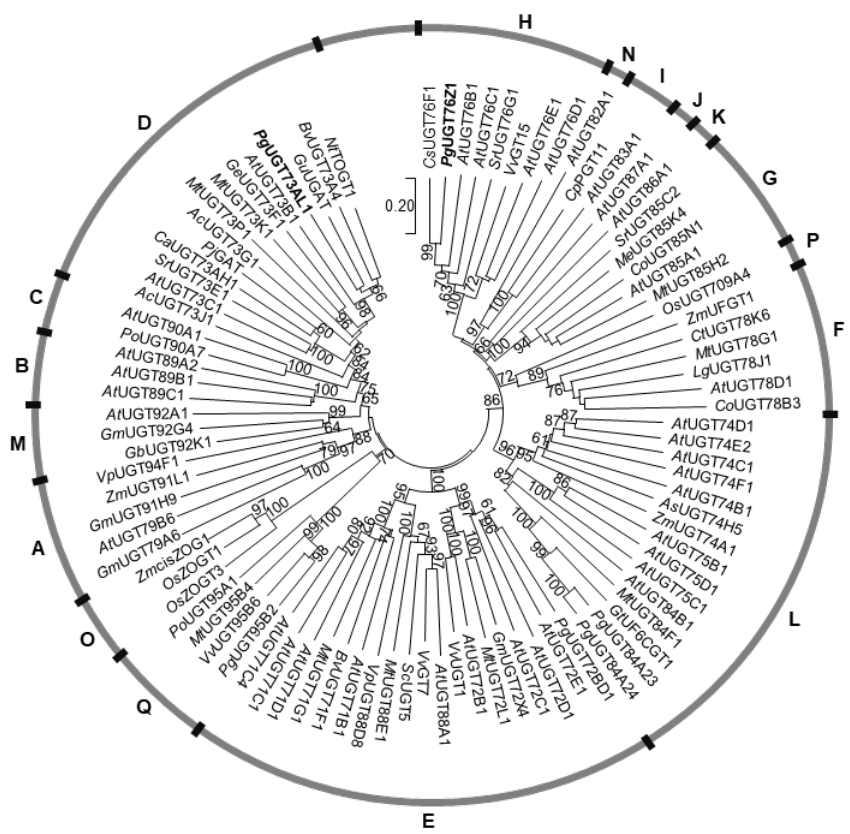
Figure 3. Phylogenetic analysis of Pg UGT73AL1, Pg UGT76Z1, and selected plant UGTs in phyloge- netic groups A-Q. The phylogenetic tree was built using the neighbor-joining method and tested with 1000 replicates. Pg UGT73AL1 and Pg UGT76Z1 are highlighted in bold. Bootstrap values greater than 60 are shown.